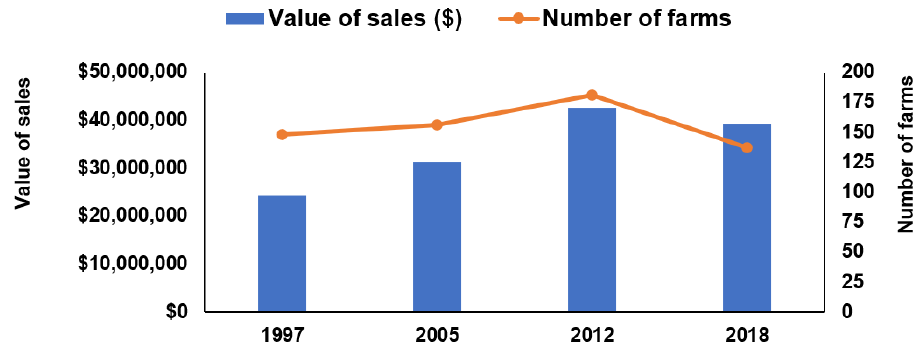
Figure 2. U.S. tilapia sales and number of farms, 1997 to 2018. SOURCE: USDA-NASS.